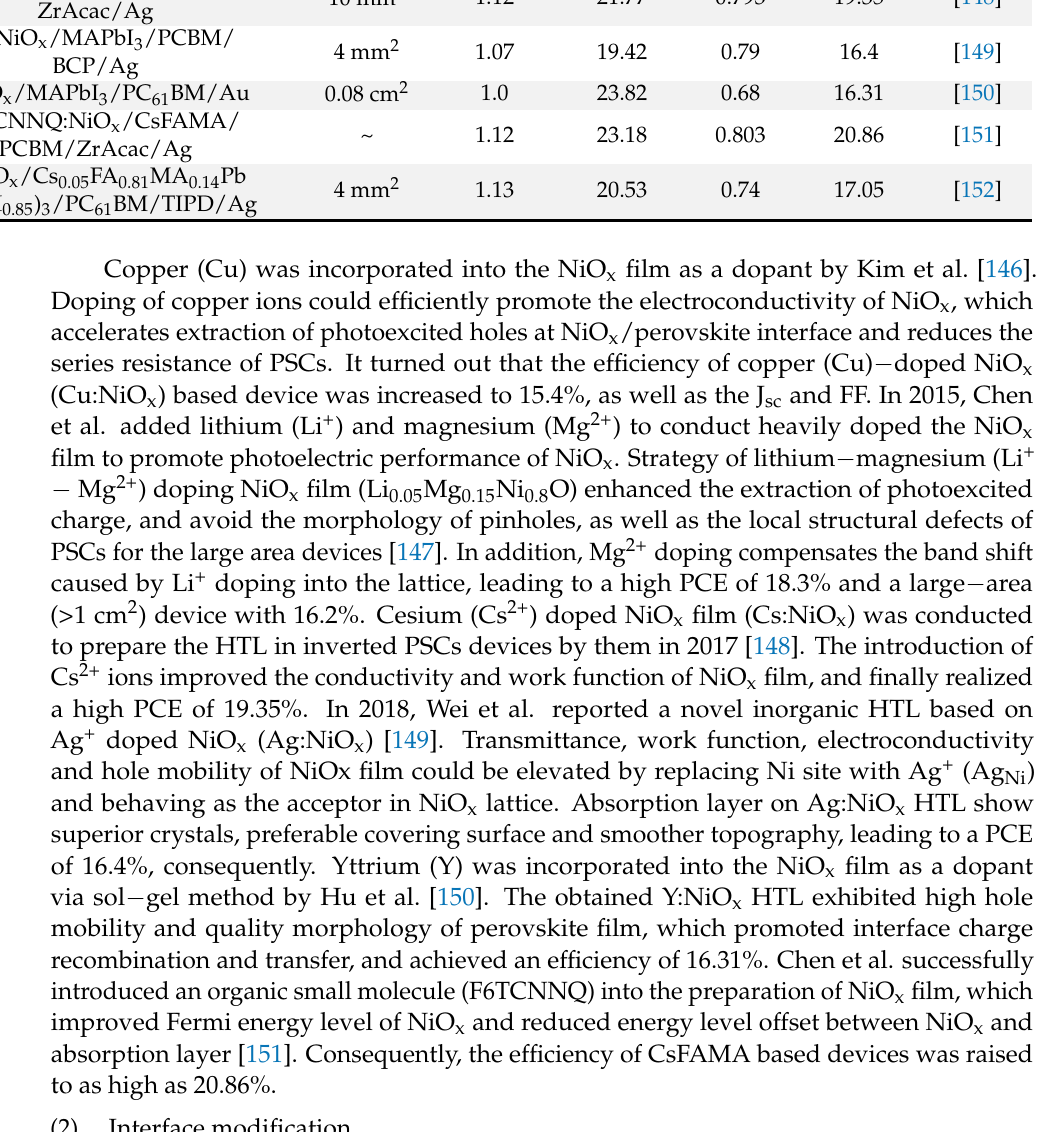
J sc FF PCE (%) (mA/cm 2 )